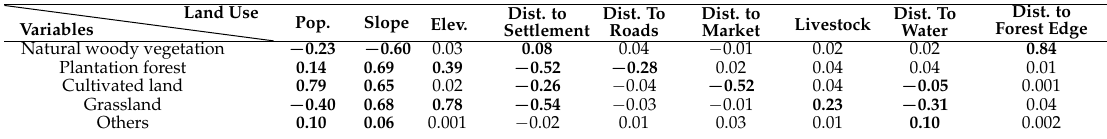
Dist. to Forest Edge